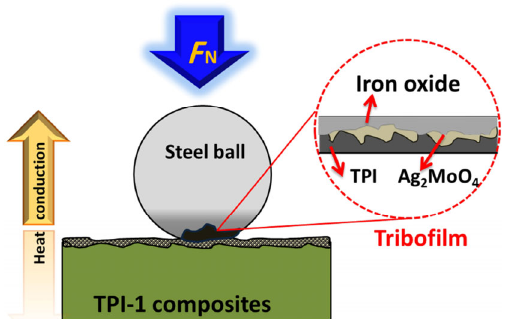
Fig. 8 Schematic of sandwich-like tribofilms formation at higher temperature on the steel